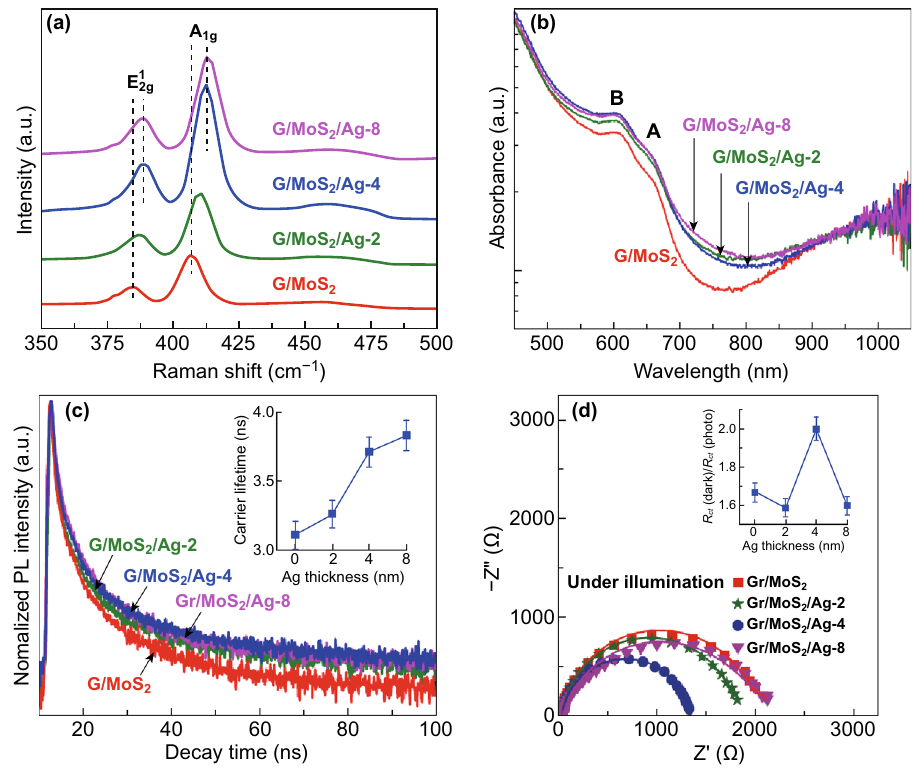
Fig. 5 a Raman spectra, b UV–Vis absorption, c TRPL results, and d Nyquist plots of G/MoS 2 , G/MoS 2 /Ag‑2, G/MoS 2 /Ag‑4, and G/MoS 2 / Ag‑8. The inset in c shows the carrier lifetimes based on the corresponding TRPL measurements. The inset in d shows the R ct (dark)/ R ct (photo) values of G/MoS 2 , G/MoS 2 /Ag‑2, G/MoS 2 /Ag‑4, and G/MoS 2